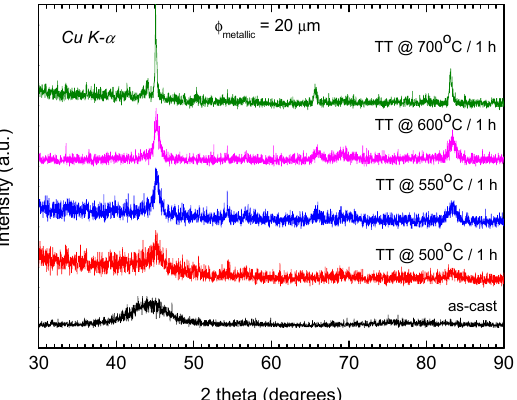
Figure 2. The evolution of the microstructure with the annealing temperature for glass-removed Fe 73.5 Si 13.5 B 9 Cu 1 Nb 3 microwires having 20 µm metallic core diameter. The optimum annealing tem- perature range is between 500 and 600 °C, where the nanocrystal size varies between 10 and 20 nm. XRD results and Transmission Electron Microscopy (TEM) images both show that all the samples exhibit similar evolutions of their microstructures with annealing, irrespective of their preparation methods or diameters (Figure 3). Any differences that appear are ascribed to the different levels and distribution of residual internal stresses that affect the magnetic anisotropy and, consequently, the value of the exchange length below which the nanosized grains interact. This interaction is influenced by the number and density of the bcc α -Fe(Si) nanograins, which vary with the sample diameter, as shown by the STEM images in Figure 3a–c. However, it is important to note that the size and structure of the nanocrystals are similar, irrespective of the microwire diameter, as indicated by the ultra-high resolution TEM images and selected area electron diffraction (SAED) patterns (Figure 3d–f).